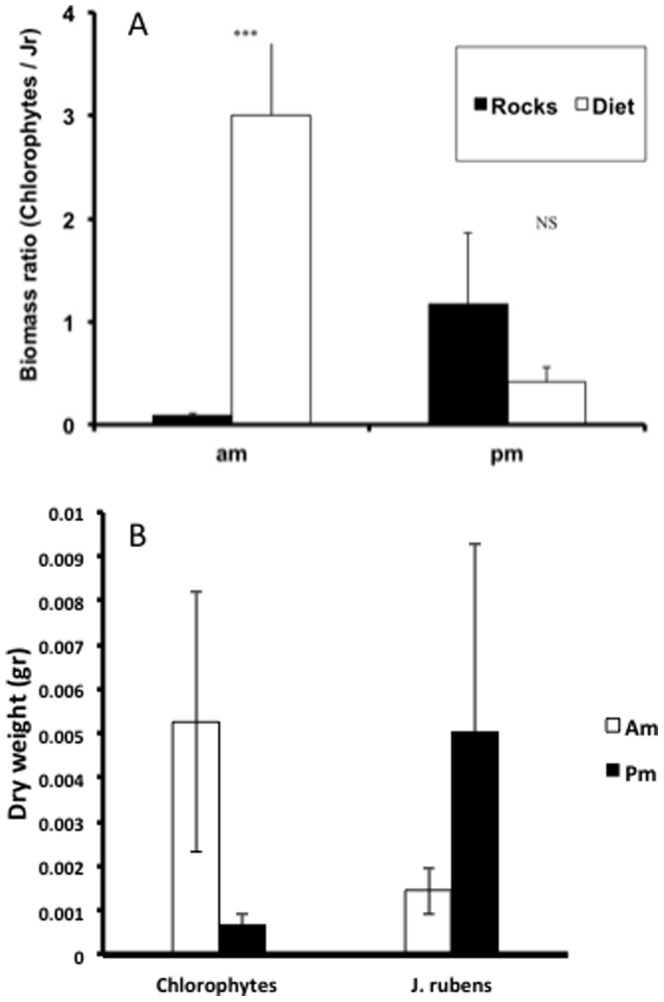
The fish selectively feed on Ulva sp. in the morning hours.
A Average (±SE) ratio between green algae (Chlorophytes) and the red alga J. rubens (Jr) in the esophagi of A. nigrofuscus (diet) and on ambient rocks at 10:00 (am) and 17:00 (pm). The rocks were collected at the same time and site where the fish were captured at the shallow reef (*** - P<0.005; NS – non significant; Tukey Post hoc). B Average (±SE) of consumed algae (dry weight) in the esophagi of A. nigrofuscus.